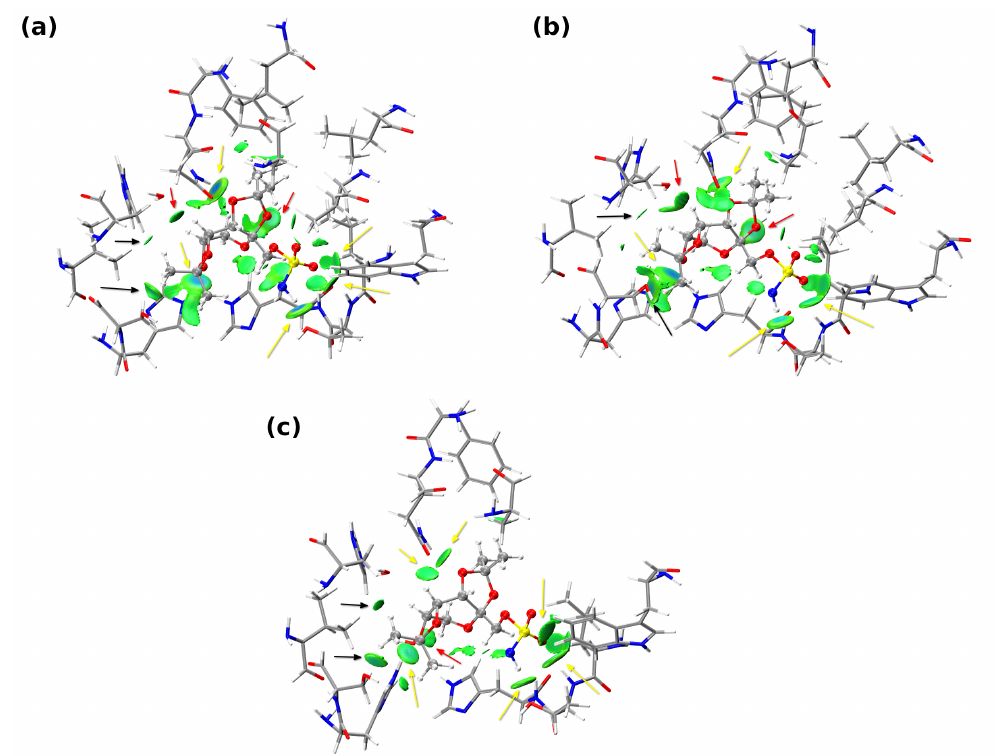
Figure 6. Colored isosurfaces (in the ED range of: − 0.05 < sign( λ 2 ) ρ < 0.05 a.u.) of ∂ g = 0.005 a.u. for the large model of the binding site of CA I. Structures were taken from the course of QM/MM Molecular Dynamics. ( a ) snapshot at 5 ps, ( b ) snapshot at 10 ps, and ( c ) snapshot at 15 ps. Ligand atoms are depicted using the CPK representation, whereas amino acids of the binding site are visual- ized as licorices. Color coding: grey—carbon, white—hydrogen, red—oxygen, blue—nitrogen, and yellow—sulfur. Yellow arrows point to the isosurfaces that indicate the most pronounced interactions with the protein, while red arrows indicate the presence of interactions with water